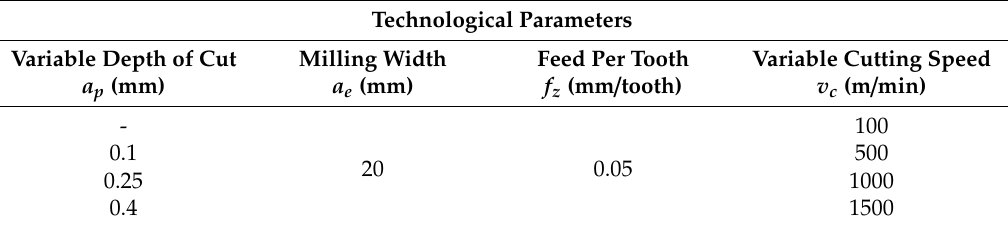
Table 3. The technological parameters used.